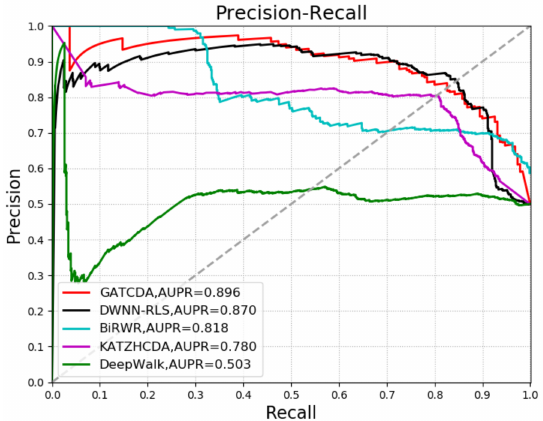
Figure 5. Comparison of five methods in PR curves and AUPRs